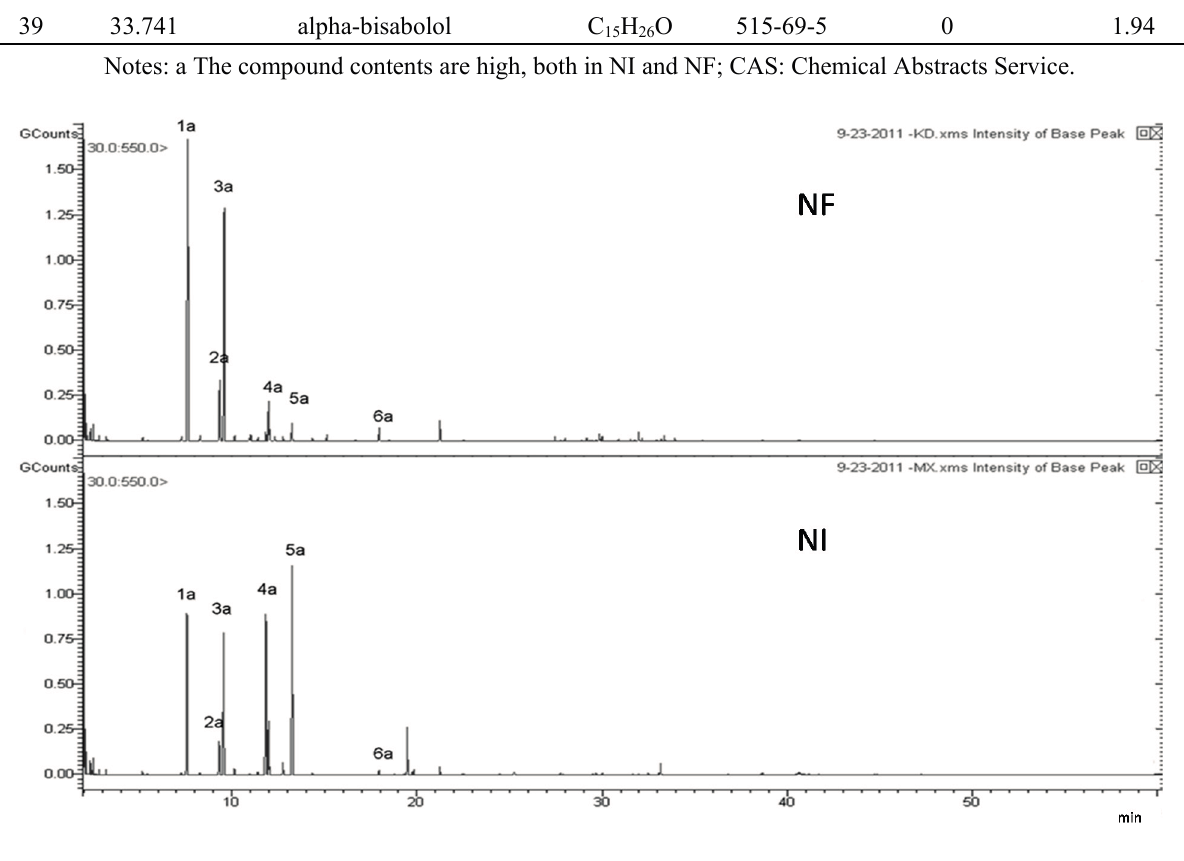
Figure 1. GC-MS chromatography profiling of Notopterygium franchetii (NF) and Notopterygium incisum